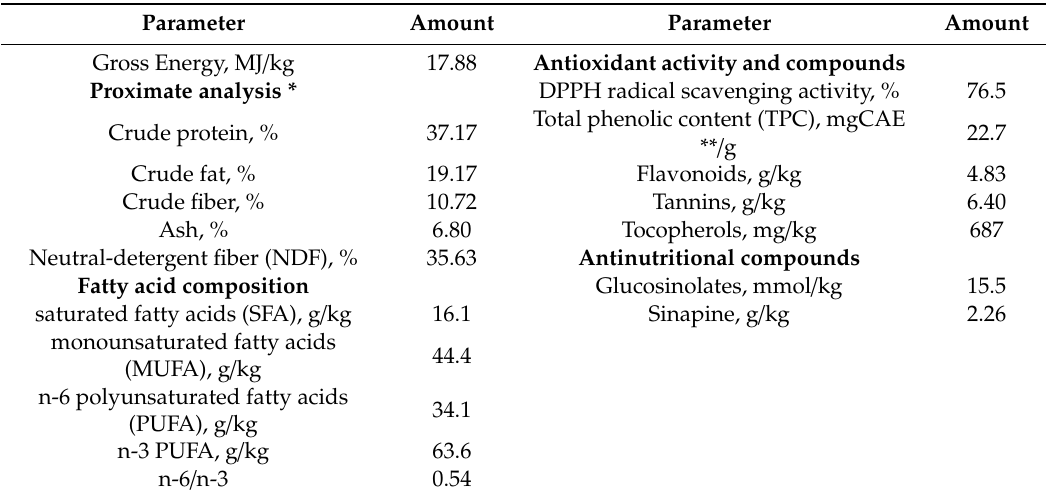
Table 1. Characterization of camelina